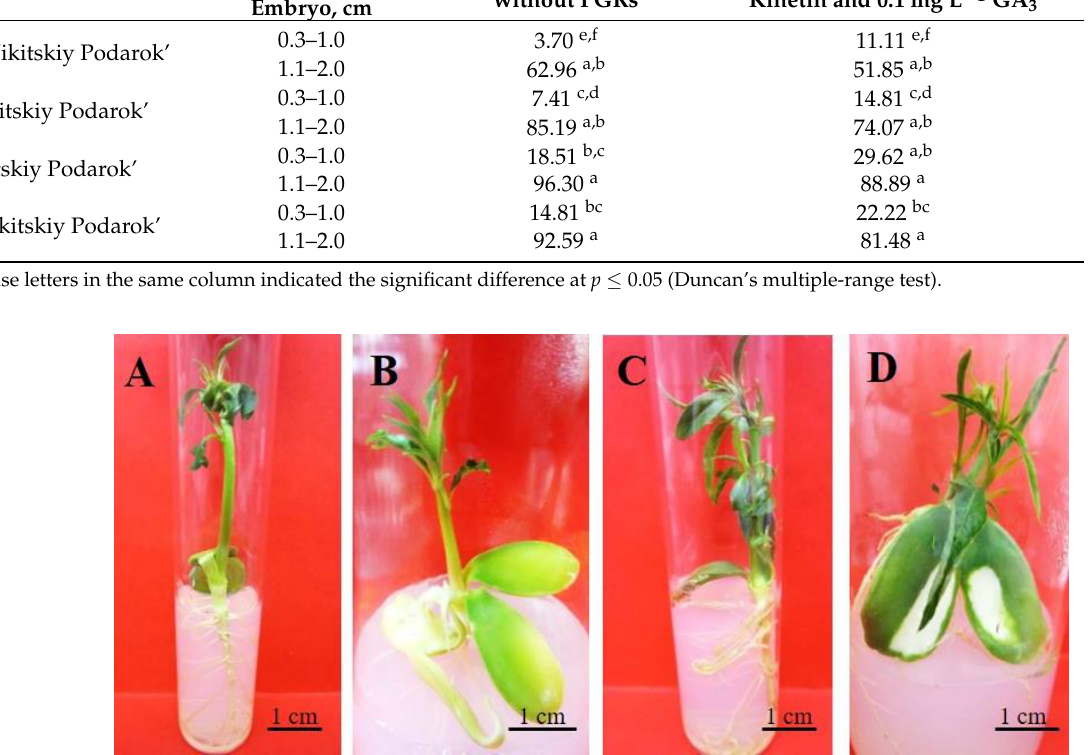
Figure 2. Plantlet regeneration from hybrid embryo in Prunus persica : ( A ) ‘Clyde Wilson’ × ‘Nikitskiy Podarok’, ( B ) ‘Jerseyglo’ × ‘Nikitskiy Podarok’, ( C ) ‘Loadel’ × ‘Nikitskiy Podarok’, ( D ) ‘Summerglo’ Ч ‘Nikitskiy Podarok’.